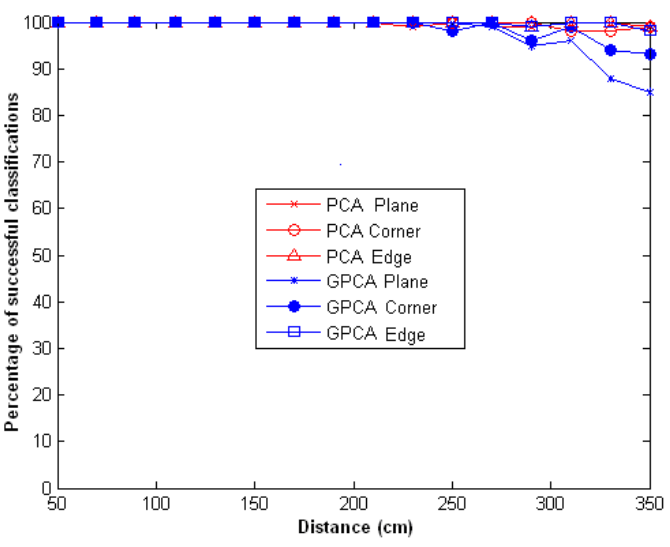
Figure 3. Percentage of successful classifications using GPCA and PCA, for l = l and m = 2.